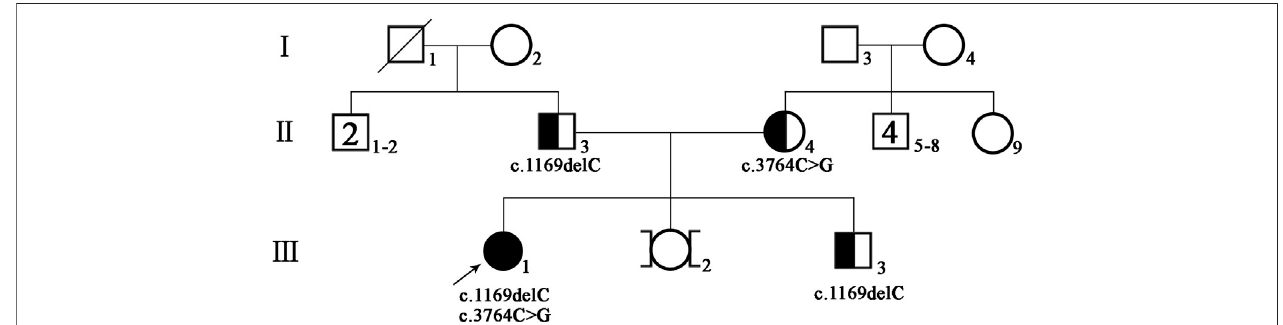
FIGURE1| Pedigreeofthepatient ’ sfamily;black- fi lledshapesrepresentindividualswithhearingloss,andtheun fi lledshapesrepresentunaffectedones.Malesare represented by squares, females by